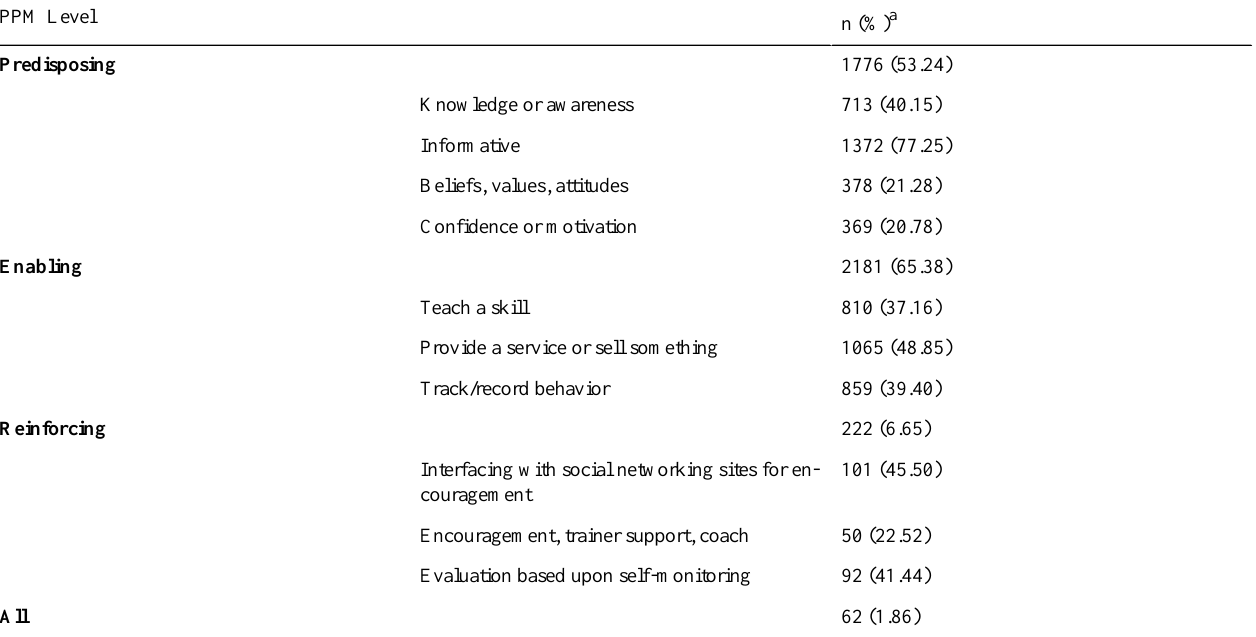
Table 3. Theoretical classification of apps (N =